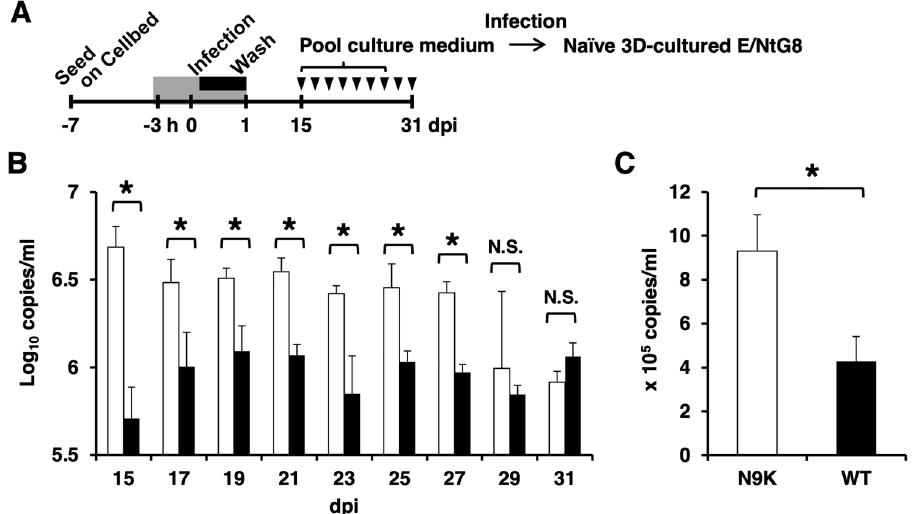
Figure 4. ( A ) Schema of the schedule for HBVbb (genotype C) infection experiment using E/NtG8 cells cultured on Cellbed is shown. Inoculation time of the 3D-cultured cells with HBVbb is shown in the black box. The time of treatment with HBV preS1 peptide is shown in the gray box. After infection, the cells were cultured for 1 month. The culture medium was collected every 2 days (arrowheads) from 15 to 31 dpi. ( B ) The amount of extracellular HBV DNA in each culture medium from 15 to 31 dpi of the cells treated with the inoculum containing HBV preS1 peptide, WT (white bars) or N9K (black bars), was evaluated by qPCR. ( C ) The infection experiment was done as Fig. 3 but using pooled culture medium from 15 to 27 dpi shown in Fig. 4A and 3D-cultured E/NtG8 cells as the infectious source and target cells, respectively. The amount of extracellular HBV DNA at 15 dpi was evaluated by qPCRs. Levels of significance: * and N. S. indicate “p < 0.05” and “no significant difference”,